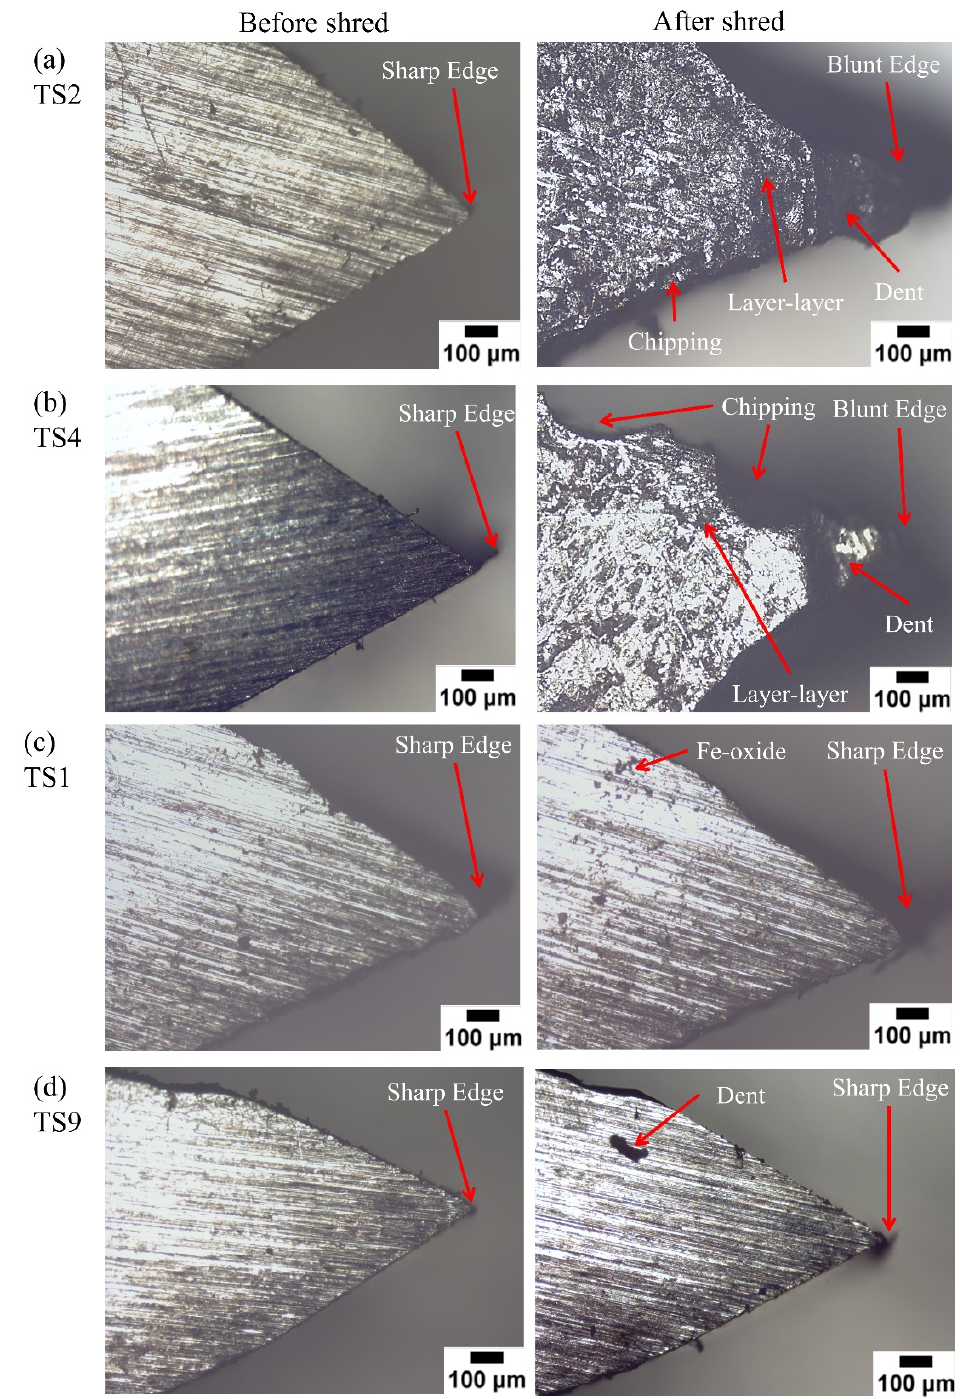
Figure 10. Optical microscope images of triple ‐ edge blades arranged in spiral orientation, before and after shredding of PET plastic: ( a ) TS2, ( b ) TS4, ( c ) TS1, ( d ) TS9. Optical microscope images (Figure 10a,b) confirmed the TS2 and TS4 blades’ wear ‐ offs were more visible, where the sharp edge became blunt. Chipping, scratches, and dent are also visible. On the other hand, TS1 and TS9 edges remain sharp, as shown in Figure 10c,d. Changing the orientation of the double ‐ edge and triple ‐ edge blades on the shredding machine shifts the loading concentration of PET plastic waste material. As the double ‐ edge blades were arranged in V ‐ orientation, the blade wear rate is high for the second (DV2), fourth (DV4) and eighth (DV8) blades, with DV2 experiencing the highest wear